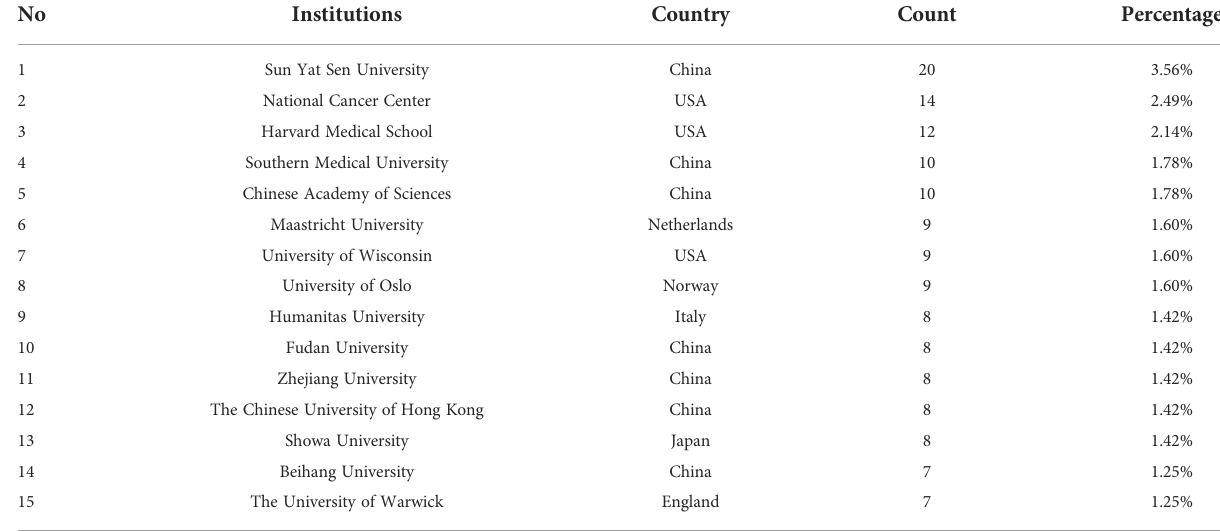
TABLE 2 Top 15 of most productive